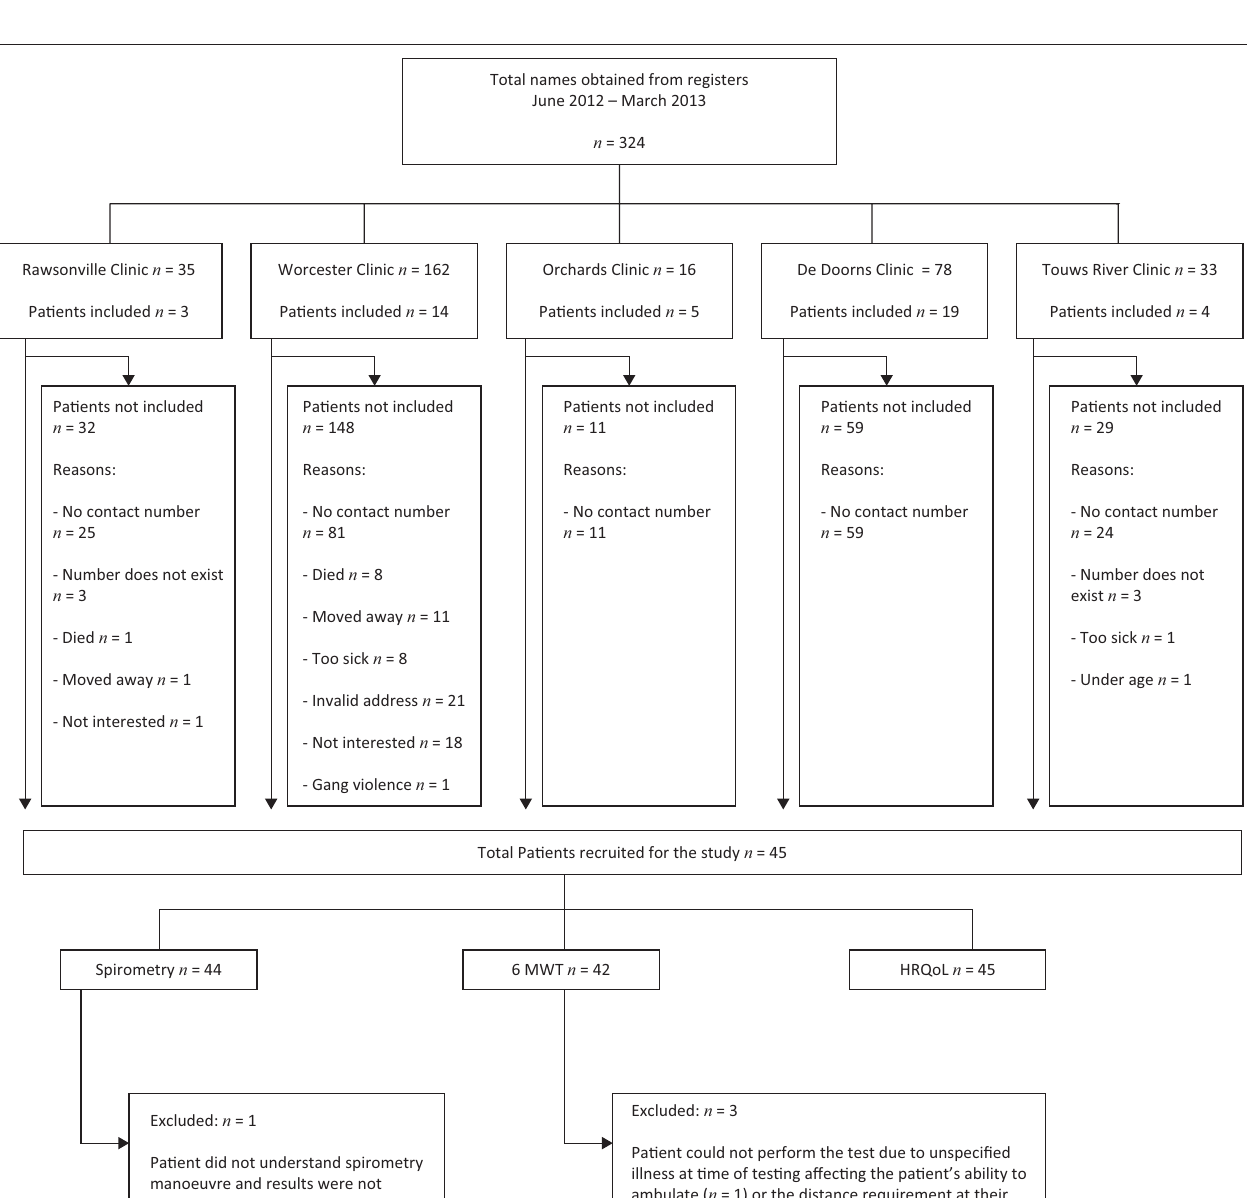
FIGURE 1: Procedure for data collection at clinics and patient homes.